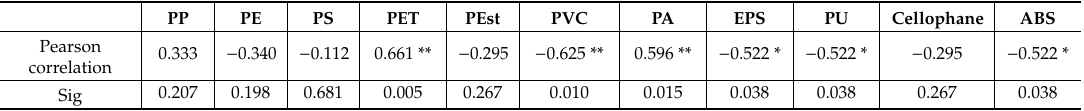
Table 4. The correlation analysis results of each microplastic component content and microplastic concentration.